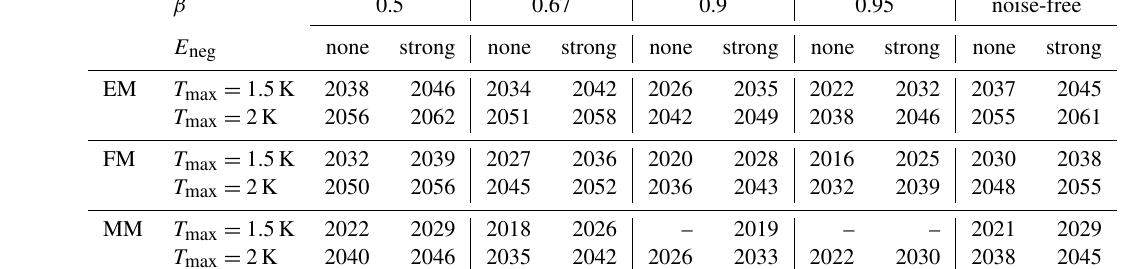
Table 4. Point of no return as a function of threshold and safety probability β without and with strong negative emissions. β